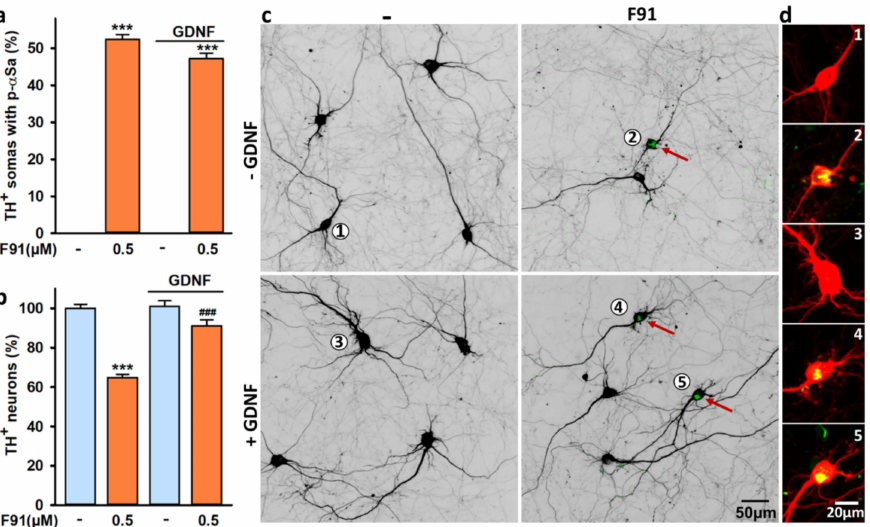
Figure 10. DA cell loss induced by α S seeded aggregation in midbrain cultures is preventable by GDNF. ( a ) Percentage of TH + neurons with somal aggregates in four-week midbrain cultures exposed three weeks earlier to 0.5 µ M F91 in the presence or the absence of 20 ng/mL GDNF. Data are means ± SEM ( n = 4–6). *** p < 0.001, vs. controls. One-way ANOVA followed by SNK test. ( b ) Survival of TH + neurons in midbrain cultures exposed to same treatments as before. Data are means ± SEM ( n = 4–6). *** p < 0.001, vs. controls. ### p < 0.001, vs. F91, only. One-way ANOVA followed by SNK test. ( c ) Representative microphotographs of four-week midbrain cultures exposed three weeks earlier to 0.5 µ M F91 in the presence or absence of 20 ng/mL GDNF. TH + neurons are presented under an inverted format and somal α Sa (green) are pointed out by red arrows. ( d ) Enlarged version of annotated TH + somas ( 1 – 5 ) shown under a standard fluorescent format. Large α Sa appear yellow after merging green (p- α S) and red (TH)